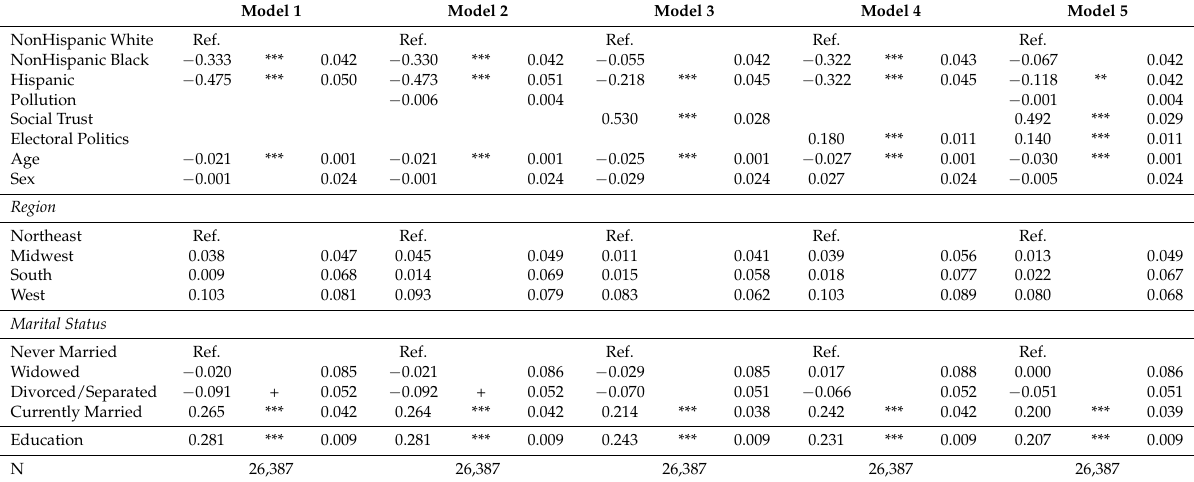
Table 4. Results from multilevel ordered logistic regression models predicting self-rated